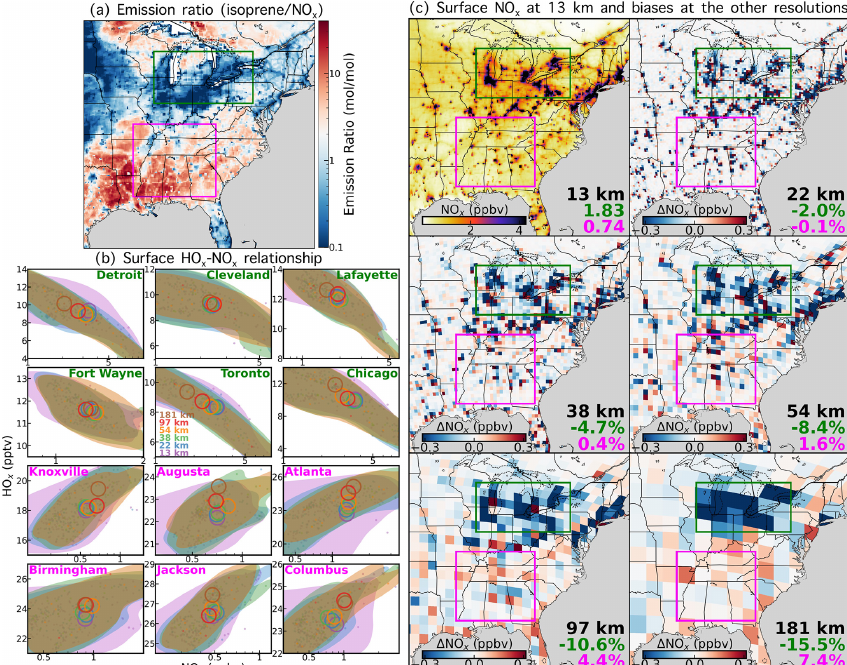
Figure 1. Afternoon (UTC19–24 or CST13–18) resolution effects of surface NO x mixing ratio driven by NO x –HO x feedbacks (e.g., Fig. A1a) over July 2015. (a) Emission ratio of isoprene vs. NO x . (b) Simulated HO x –NO x relationship at each resolution (color coded). The contour lines (for resolutions < 60km) include 90% of the scatter (points) of data within each 2 ◦ × 2 ◦ window centered over each city (based on kernel density estimation), and the circles indicated the means for all resolutions. (c) Surface NO x mixing ratio at 13km (top left) and the differences (minus 13km) at the other resolutions (other subpanels). The regional mean NO x (for 13km, in ppbv) and percentage biases (for the other resolutions) are indicated at the bottom right of each subpanel. Green and magenta (rectangles, city names and numbers) label the Great Lakes region and the southern states of the US as defined in this study,